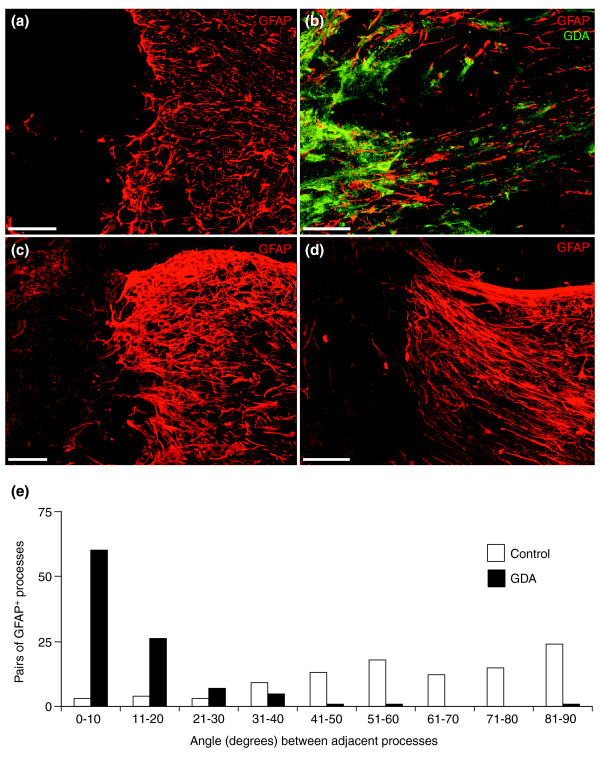
Reorganization of lesion margins by GDAs. (a,c) Control lesions; (b,d) transplanted lesions. Control lesions at (a) 4 days and particularly at (c) 8 days after injury have a dense meshwork of hypertrophic cell bodies and processes of endogenous astrocytes within lesion margins that is typical of forming glial scar tissue. (b) At 4 days after injury and transplantation, 'flares' of hPAP+ GDAs (green) are interwoven with realigned host GFAP+ astrocytes within lesion margins (the caudal margin is shown). Processes of both transplanted GDAs and host astrocytes are oriented towards the lesion center. Note that hPAP+ GDAs are not GFAP+. (d) At 8 days after injury and transplantation, GDAs have effected a reduction in host astrogliosis and a striking realignment of host GFAP+ astrocytes compared with the control (c). (e) Quantification of the alignment of host GFAP+ processes in lesion margins. The angles measured between each pair of GFAP+ processes in control (n = 100) and GDA-transplanted lesion margins (n = 100) are graphically displayed in a histogram. Each bin along the x-axis represents the angle between a pair of processes: 0° is parallel and 90° is perpendicular. The y-axis indicates the number of pairs of GFAP+ processes within each bin. Note the striking difference in alignment of GFAP+ host astrocytic processes in margins of GDA-transplanted lesions versus controls. GDA-transplanted lesions have an average angle of just 11.6° (median 7°) between paired processes, versus 59.4° (median 61°) for control lesion margins. Statistical analysis: p < 0.0001, t-test. Scale bars: (a,c,d) 100 μm; (b) 50 μm.